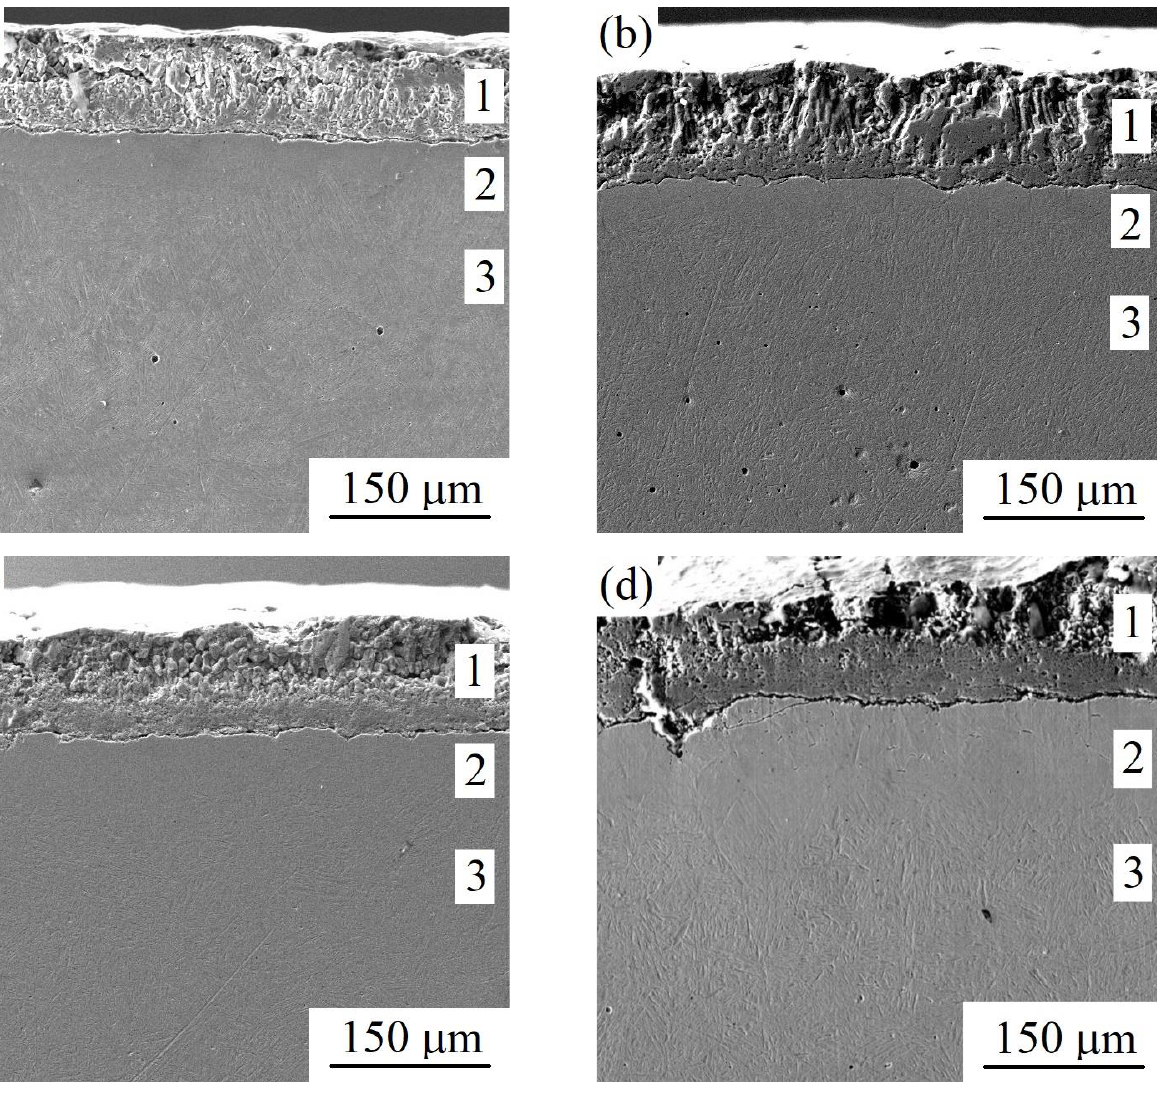
Figure 4. SEM image of cross-section of the steel surface after cathodic PENC for: ( a ) — 5 min, ( b ) — 10 min, ( c ) — 20 min, ( d ) — 30 min. The numbers on the images indicate: 1 — oxide layer; 2 — diffusion nitrocarburized layer; 3 — initial structure.